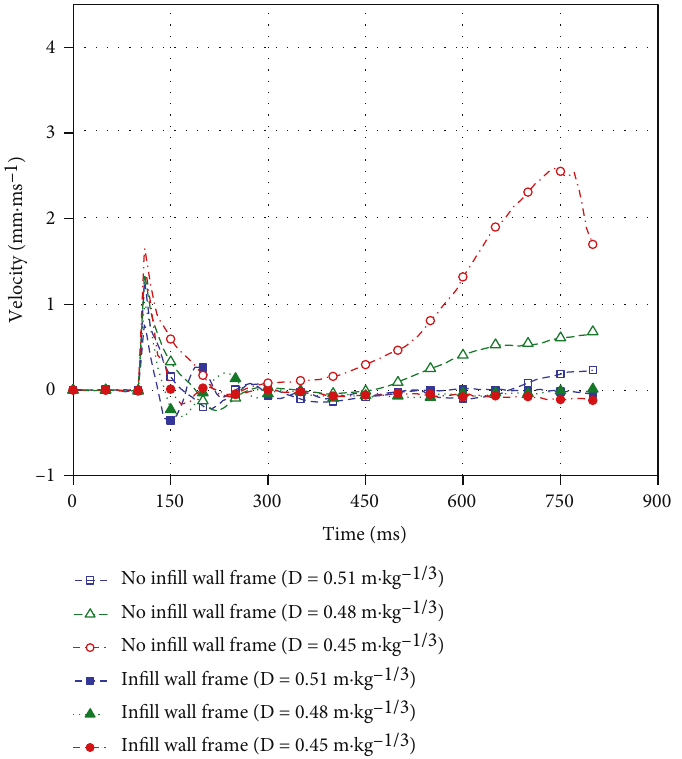
Figure 14: The Y -directional velocity at the apex of the bottom side column.